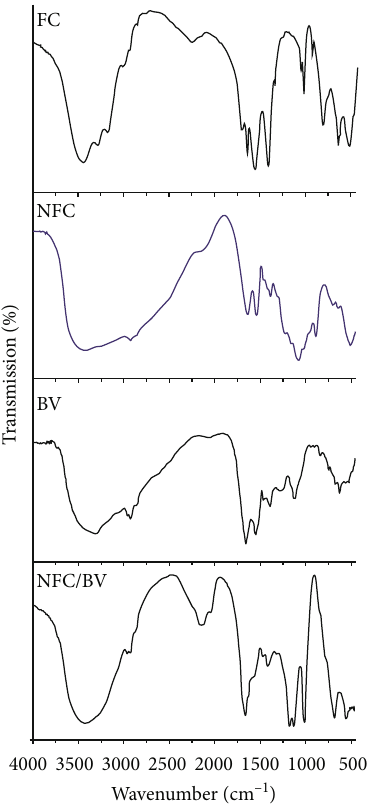
Figure 1: FTIR spectra of synthesized molecules of fungal chitosan (FC), bee venom (BV), nano-FC (NFC), and BV/NFC